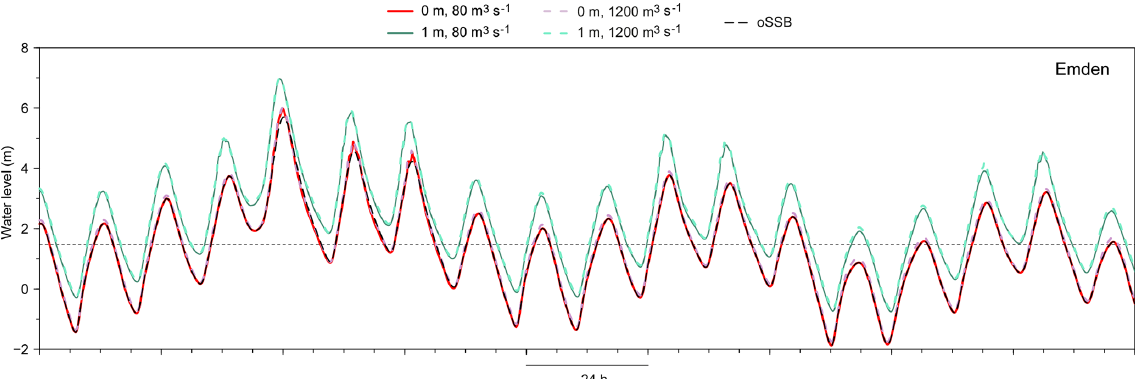
Figure 8. Longest event and event chain (EL–EC): times series of the amplified water levels as in Fig. 7. The dashed horizontal line represents